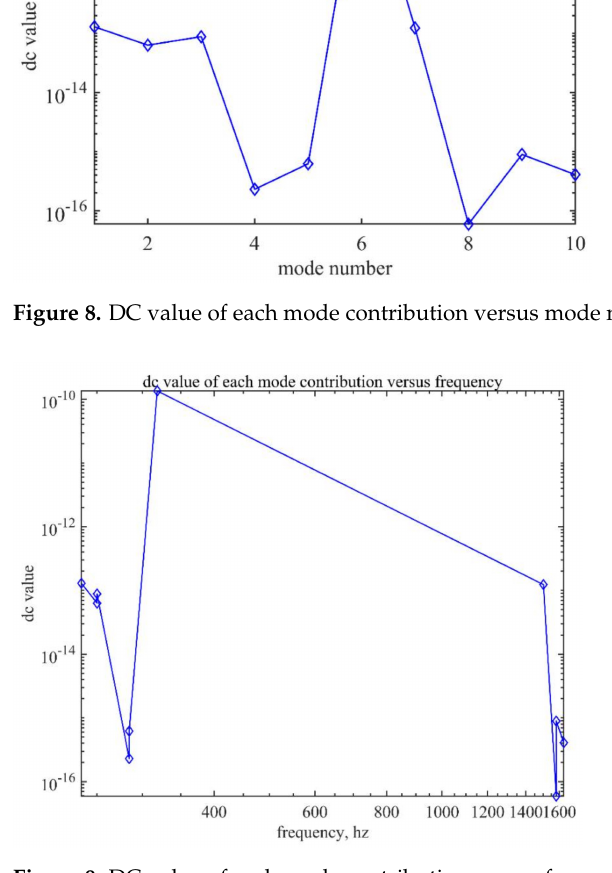
Figure 9. DC value of each mode contribution versus frequency.